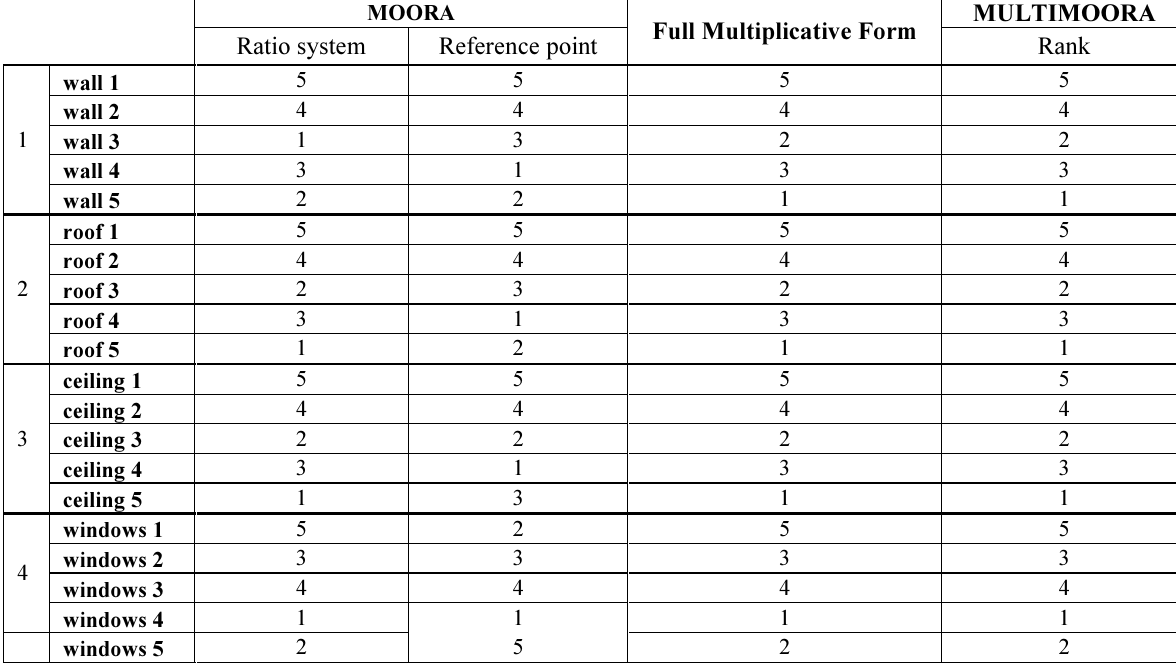
Table 5. MULTIMOORA as a consequence of the MOORA method and of the Full Multiplicative Form MULTIMOORA MOORA Full Multiplicative Form Ratio system Reference point